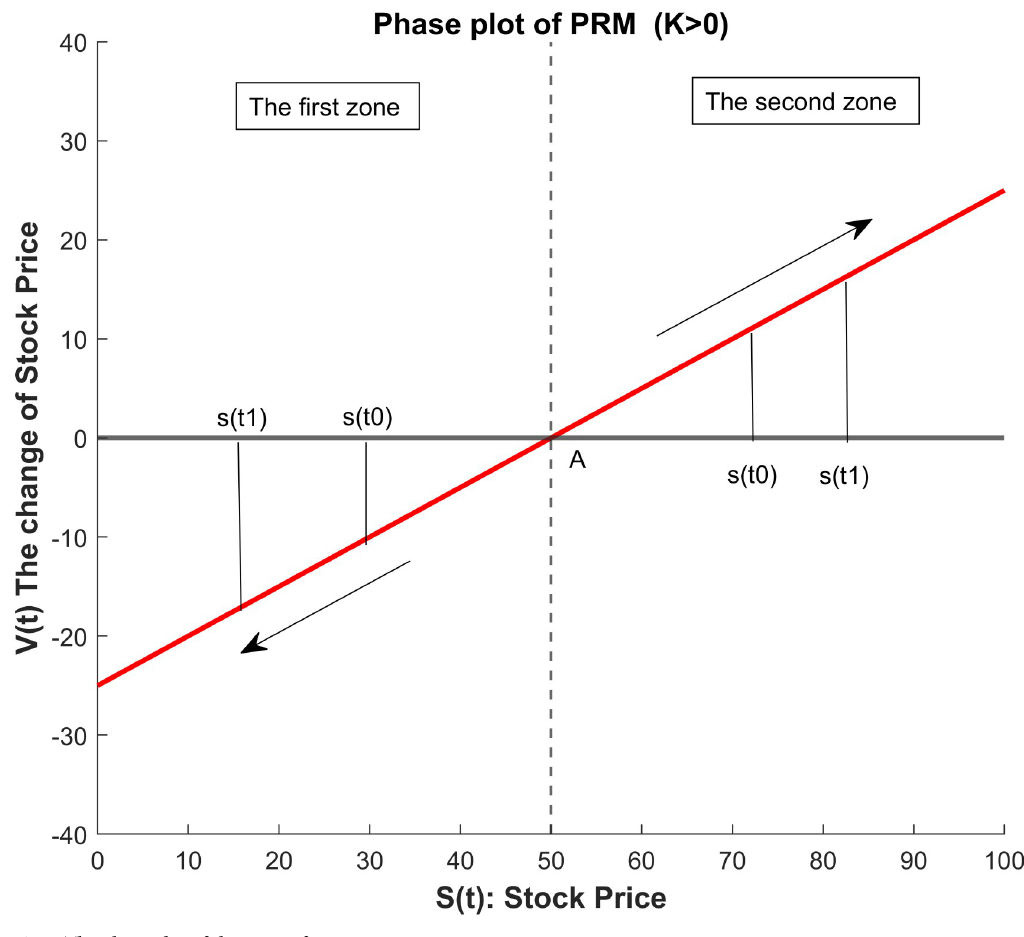
Fig 1. The phase plot of the nPRM for κ >